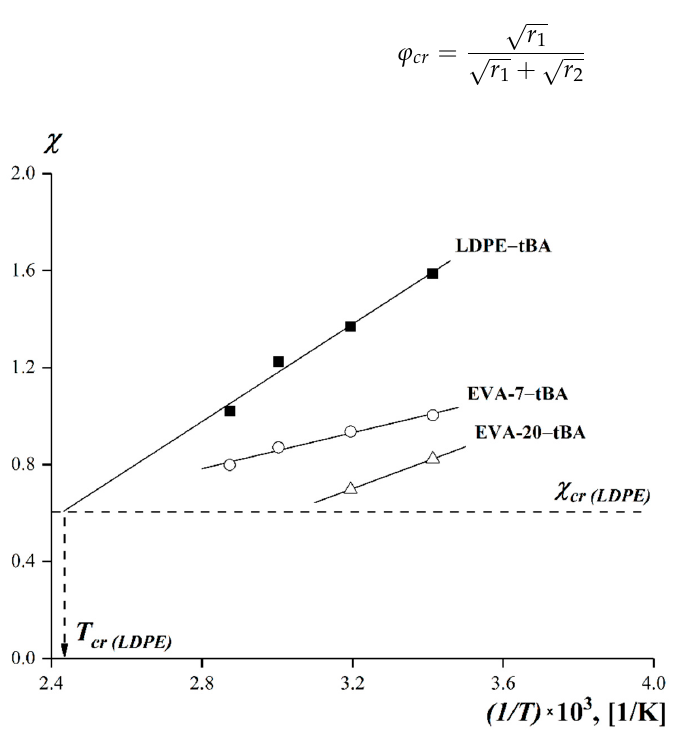
Figure 6. Temperature dependence of the Flory–Huggins parameter when mixing tBA with LDPE, EVA-7, and EVA-20.